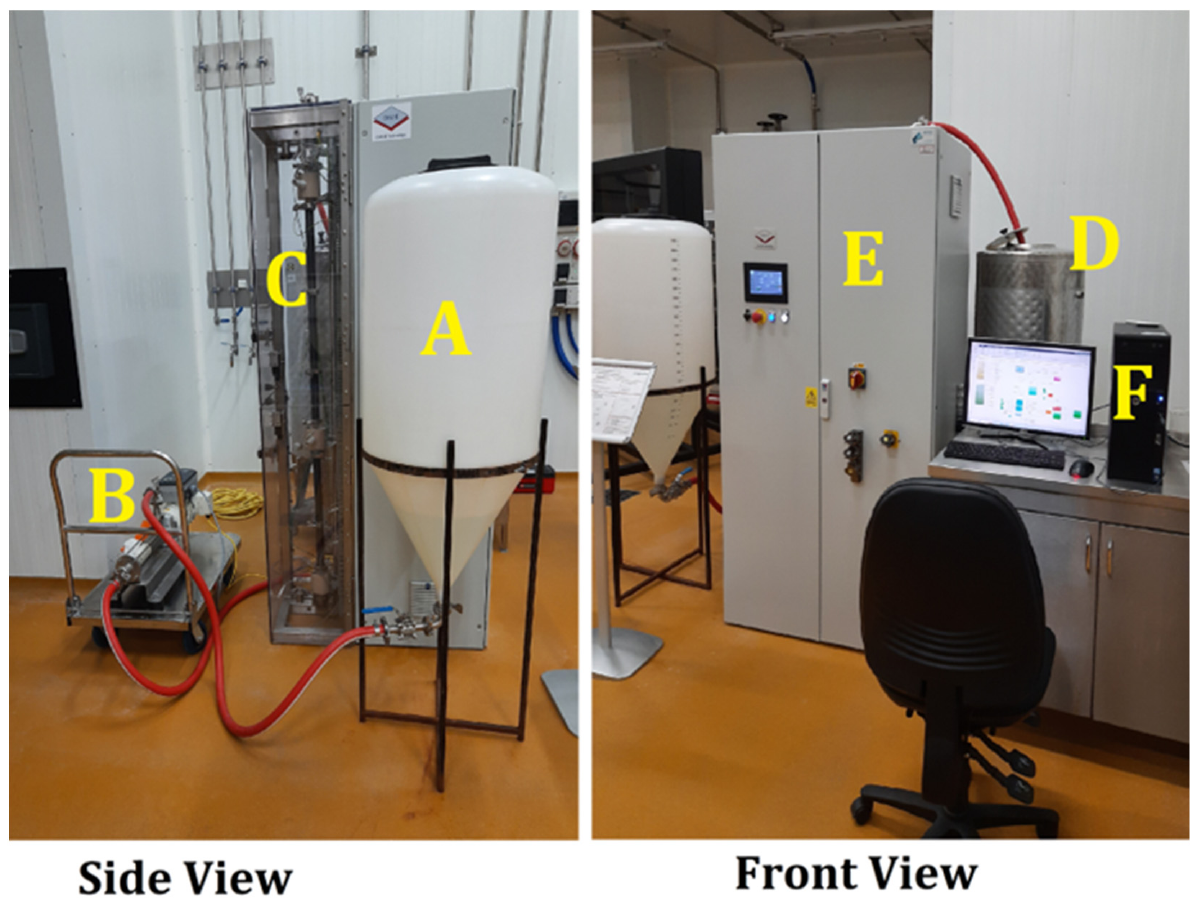
Figure 1. Continuous flow ohmic heating system pilot plant designed at NCEFE in collaboration with Ohm-E Technology (UK).